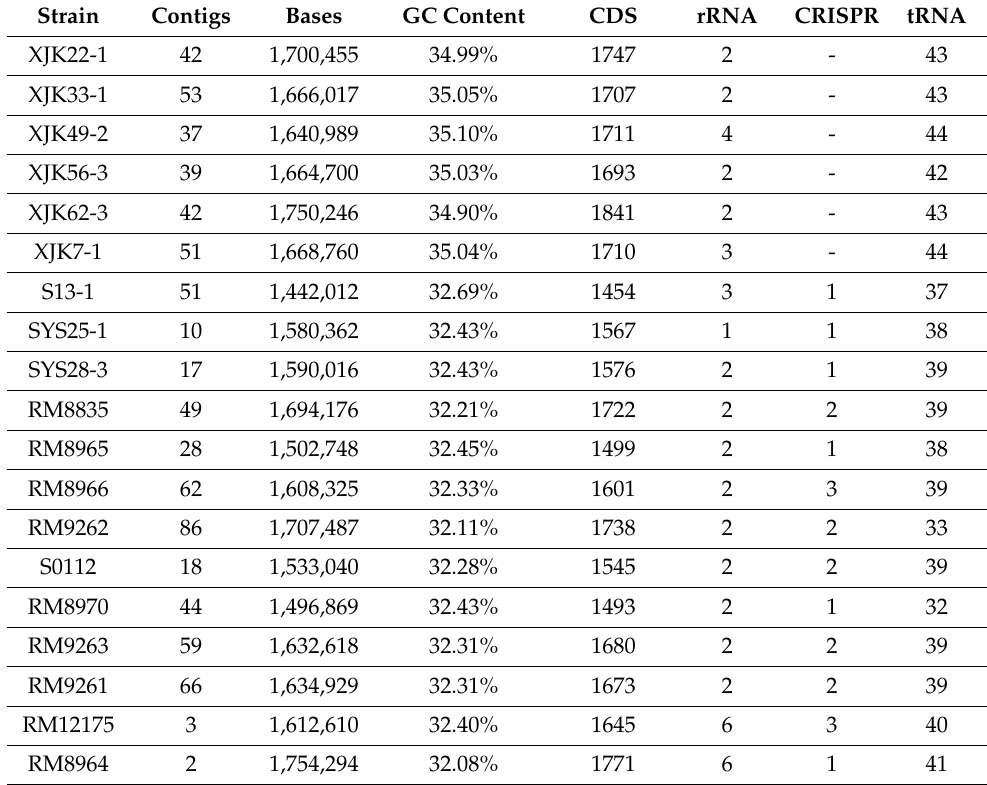
Table 4. Genomes characteristics of strains Campylobacter felis sp. nov. and Campylobacter ovis sp.